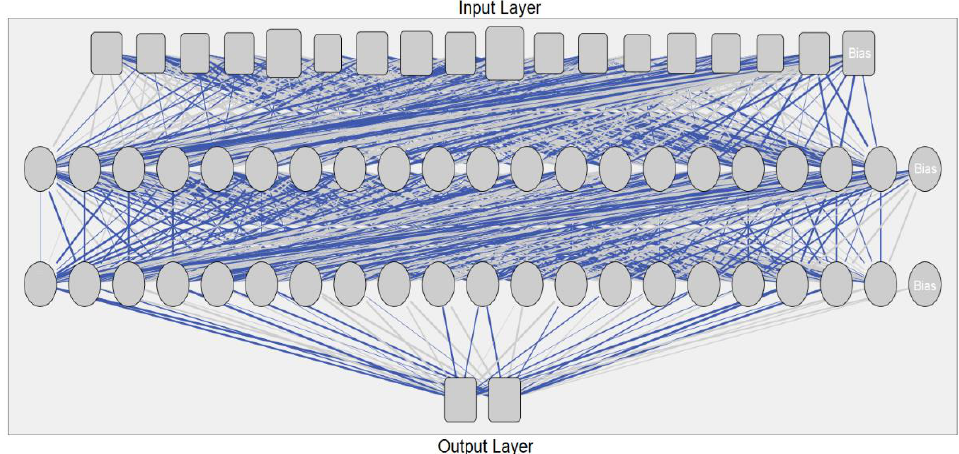
Figure 6. Multilayer architecture of the created model MLP.